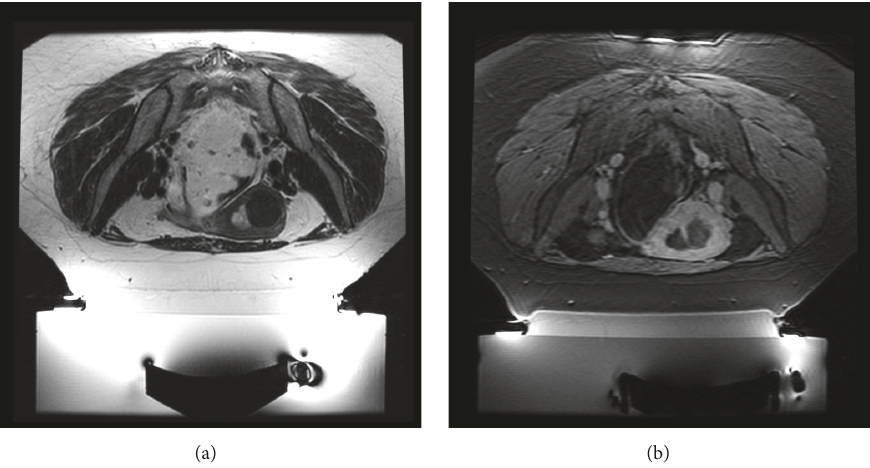
Figure 6: Case 4 : example of a treatment with a low ablation rate (NPV = 57%); (a) screening axial T2-w scan; (b) sagittal T1-w with fat saturation acquired after intravenous injection of paramagnetic contrast medium acquired at the end of the treatment.